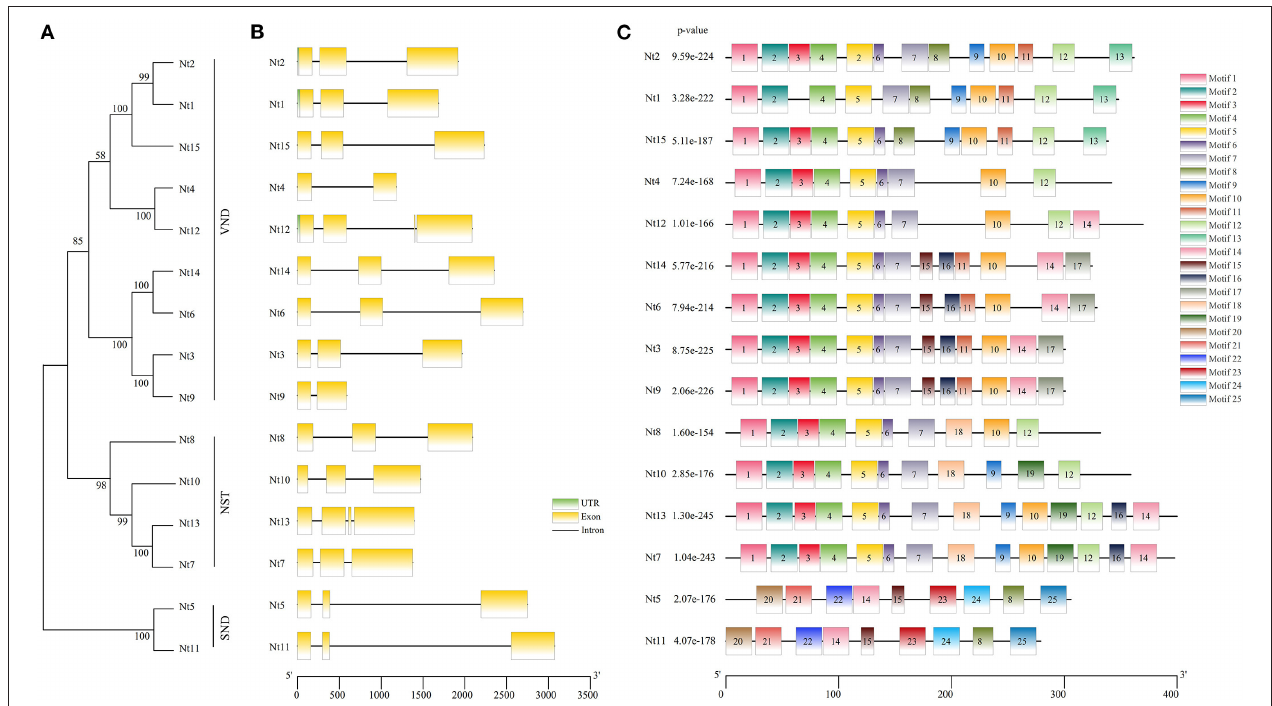
FIGURE 2 | Neighbor-joining (NJ) phylogenetic relationships, gene structure, and motif analysis of NtSWNs. (A) In the phylogenetic tree, the NtVND, NtNST, and NtSND groups were marked in a straight line on the right. (B) In gene structures, untranslated region (UTRs) were indicated by green boxes, exons were represented by yellow boxes, and introns were shown in black lines. (C) Motif compositions were detected with Multiple Em for Motiv Elicitation (MEME); in motif analysis, the motifs were represented by different colored boxes, and each gene contained 9 to 14